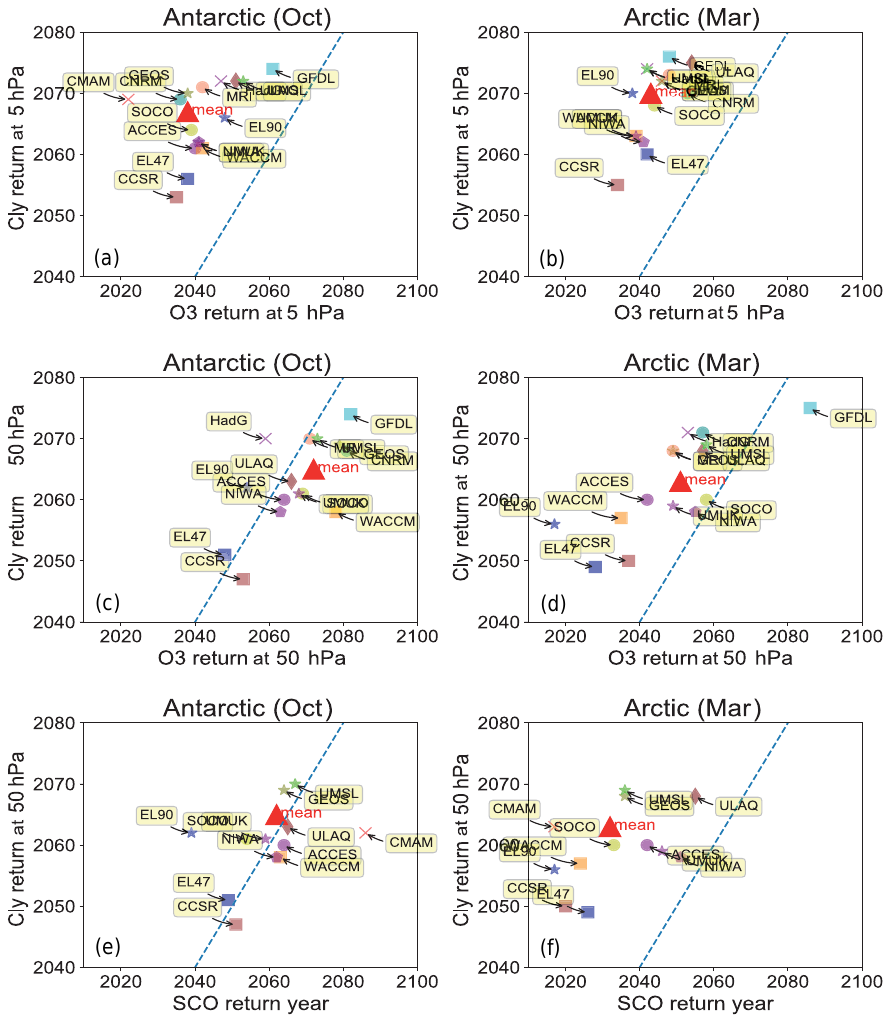
Figure 8. Correlation plots of ozone return dates against Cl y return dates for (a, c, e) the Antarctic and (b, d, f) the Arctic from REF-C2 simulations for individual models and the MMM1S at (a, b) 5hPa, (c, d) 50hPa, and (e, f) stratospheric column (SCO). The red triangle is the multi-model mean. The dashed blue line is the 1 : 1 line between Cl y and ozone return dates. The model symbols are the same as those used in Fig.